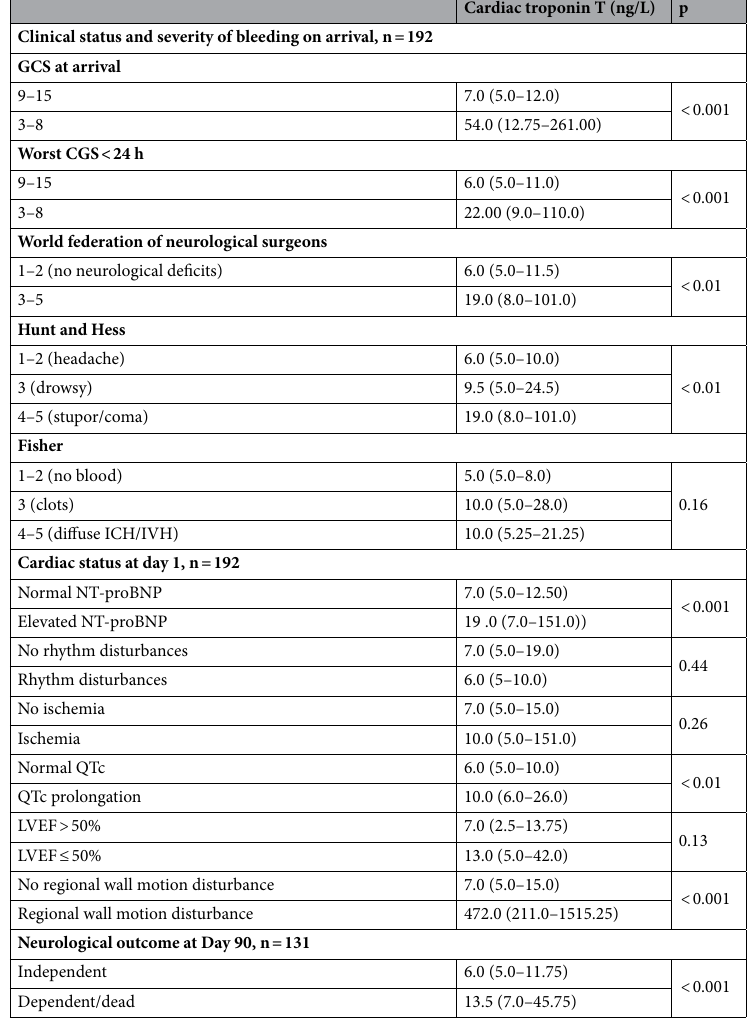
Table 5. Cardiac troponin T concentrations at day 1 according to clinical and cardiac status, and neurological outcome at day 90. Mann–Whitney U or Kruskal-Wallis-test. cTnT cardiac troponin T, GCS Glasgow coma scale, LVEF left ventricular ejection fraction, NT-proBNP N ‐ terminal pro ‐ B ‐ type natriuretic peptide, QTc corrected QT